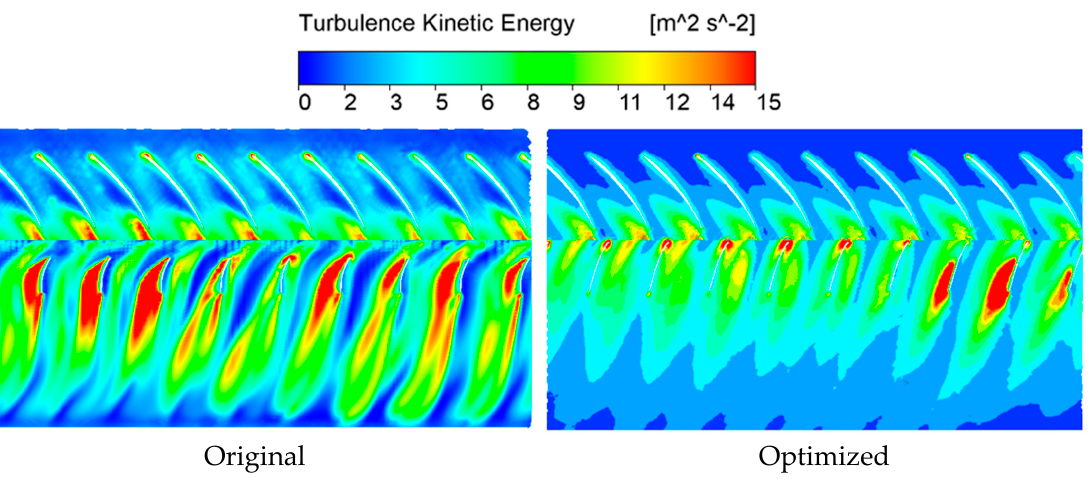
Figure 23. The turbulent kinetic energy distribution at 0.5 blade height before and after optimiza- tion.